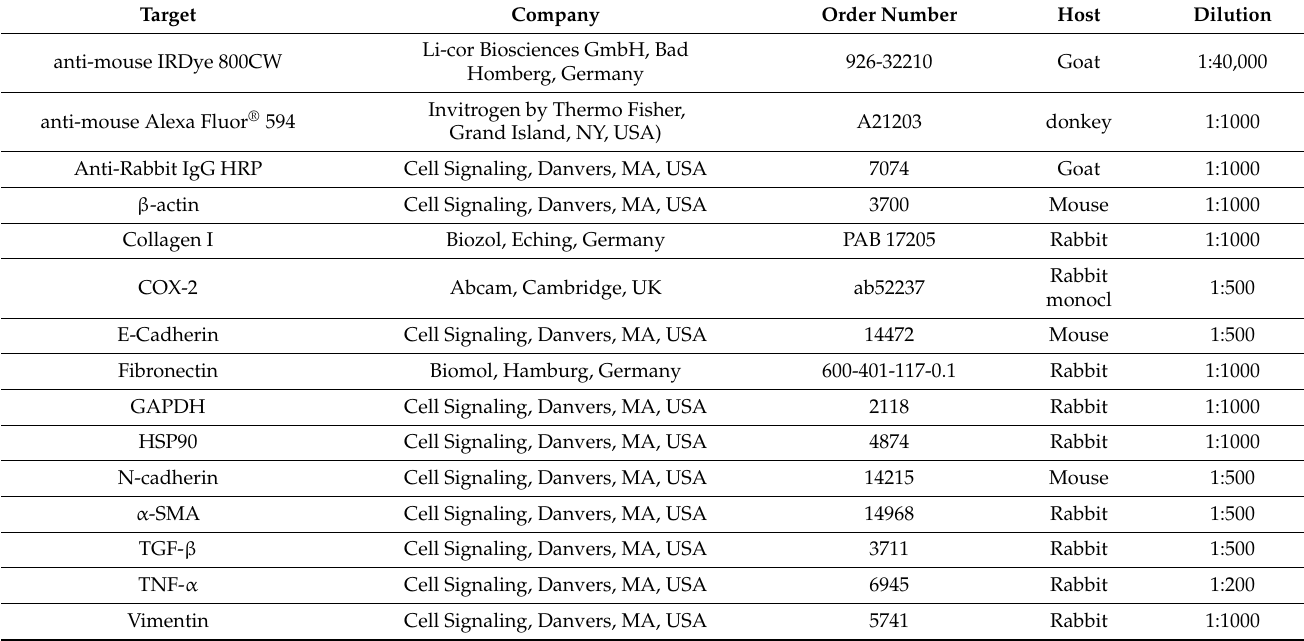
Table 1. Antibodies, order number, host and dilutions